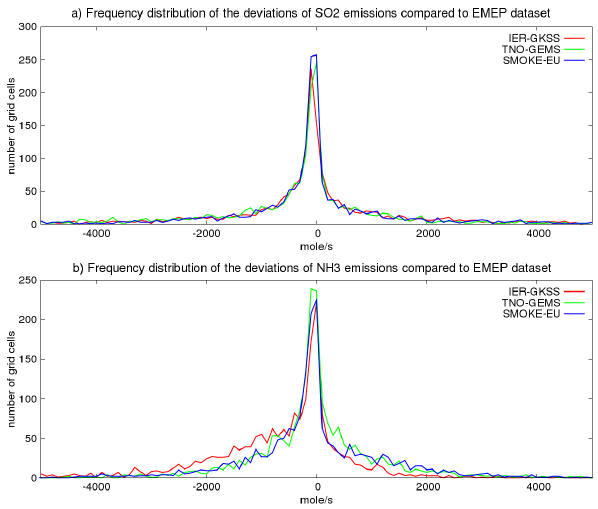
Fig. 6. Frequency distribution of different emission datasets for the year 2000 on a 54 × 54km 2 domain (Fig. 2). Only emissions of the EU27 are taken into account. (a) SO 2 emissions (b) NH 3 emissions.